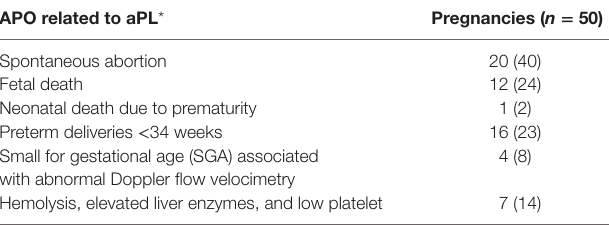
Table 3 | Lists of adverse pregnancy outcome (APO) related to aPL presence.